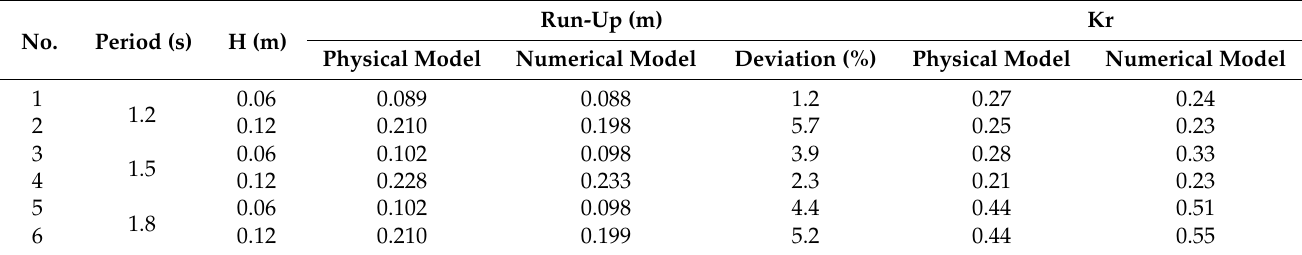
Table 3. Comparison of wave run-up and reflection coefficient between the numerical model and phys-